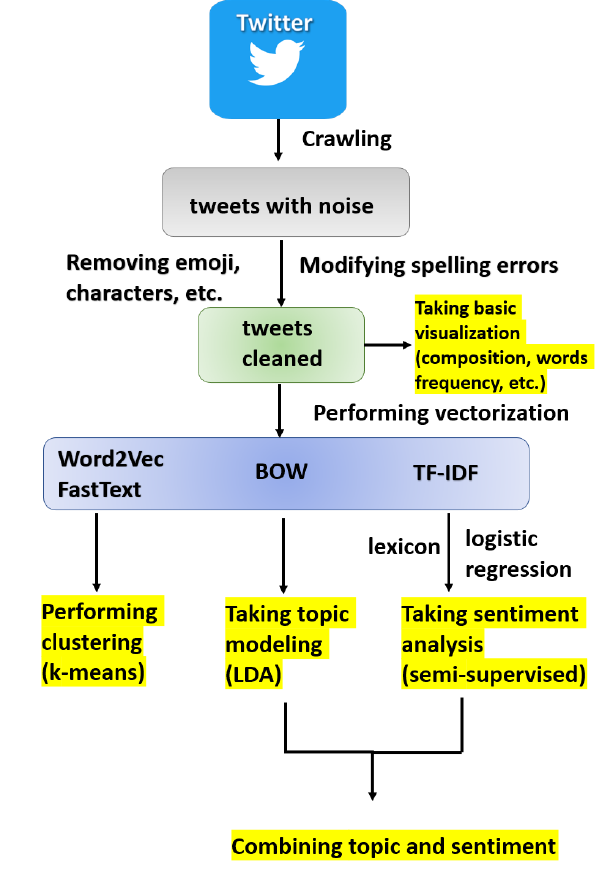
Figure 1. Methodology